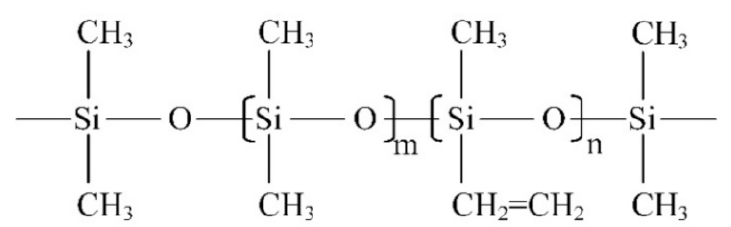
Figure 2. Polydimethylsiloxane structure diagram (m is much greater than